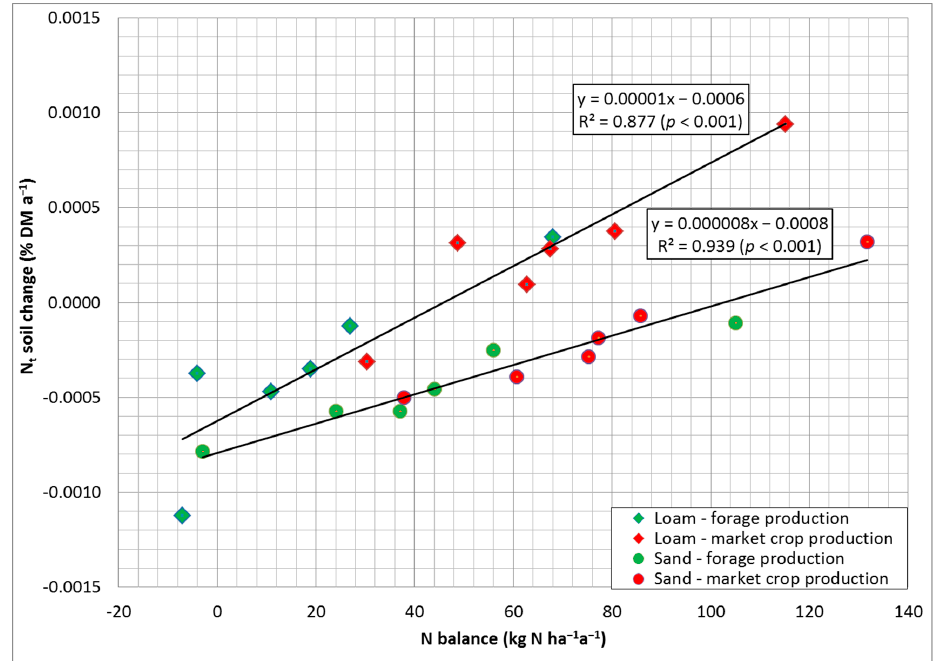
Figure 3. Relationship between increasing N balances and the annual change in C org ( above ) and N t , concentrations ( below ) of loamy and sandy soils in organic farming systems with 33% forage legumes in the crop rotations.